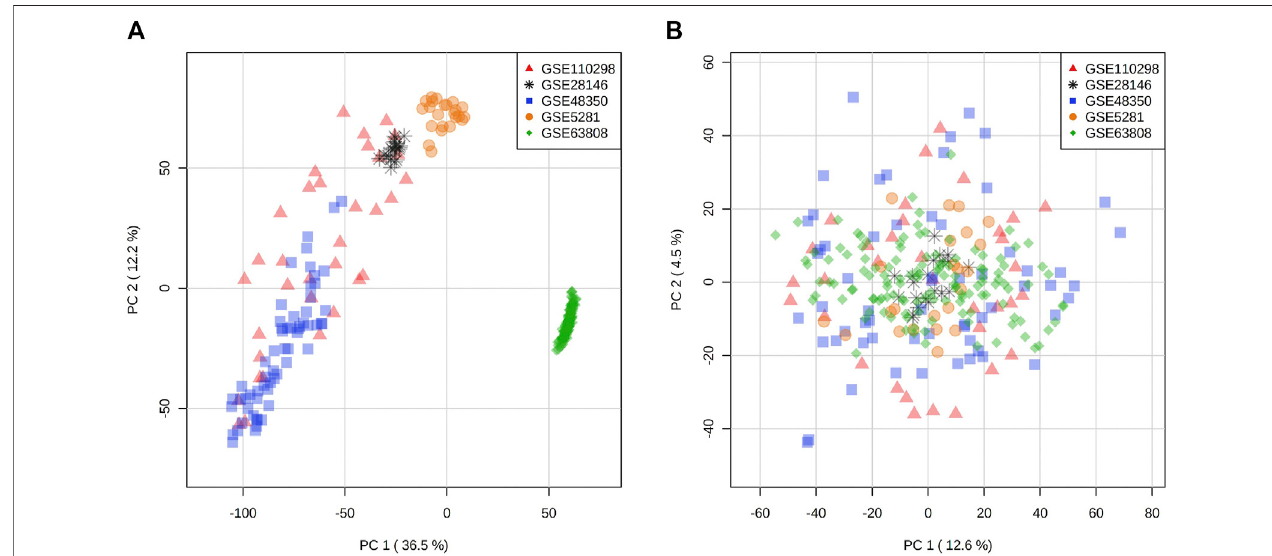
FIGURE 1 | Principal component analysis of expression distribution of all datasets (A) before batch effect adjustment and (B) after batch effect adjustment with ComBat algorithm.